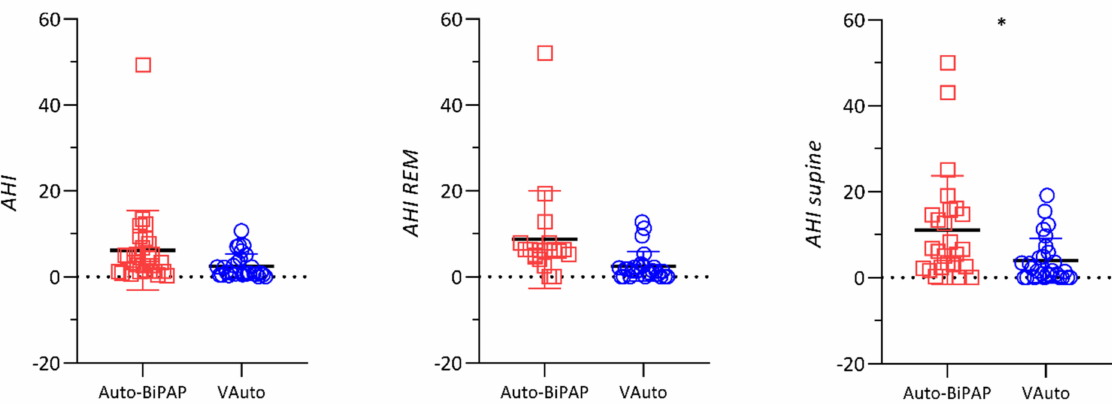
Figure 2. Dot plots represent the comparison of residual apnea-hypopnea index (AHI), AHI in REM sleep and AHI in supine sleeping position between treatment with Auto-BiPAP and VAuto (Group B). * p < 0.05.